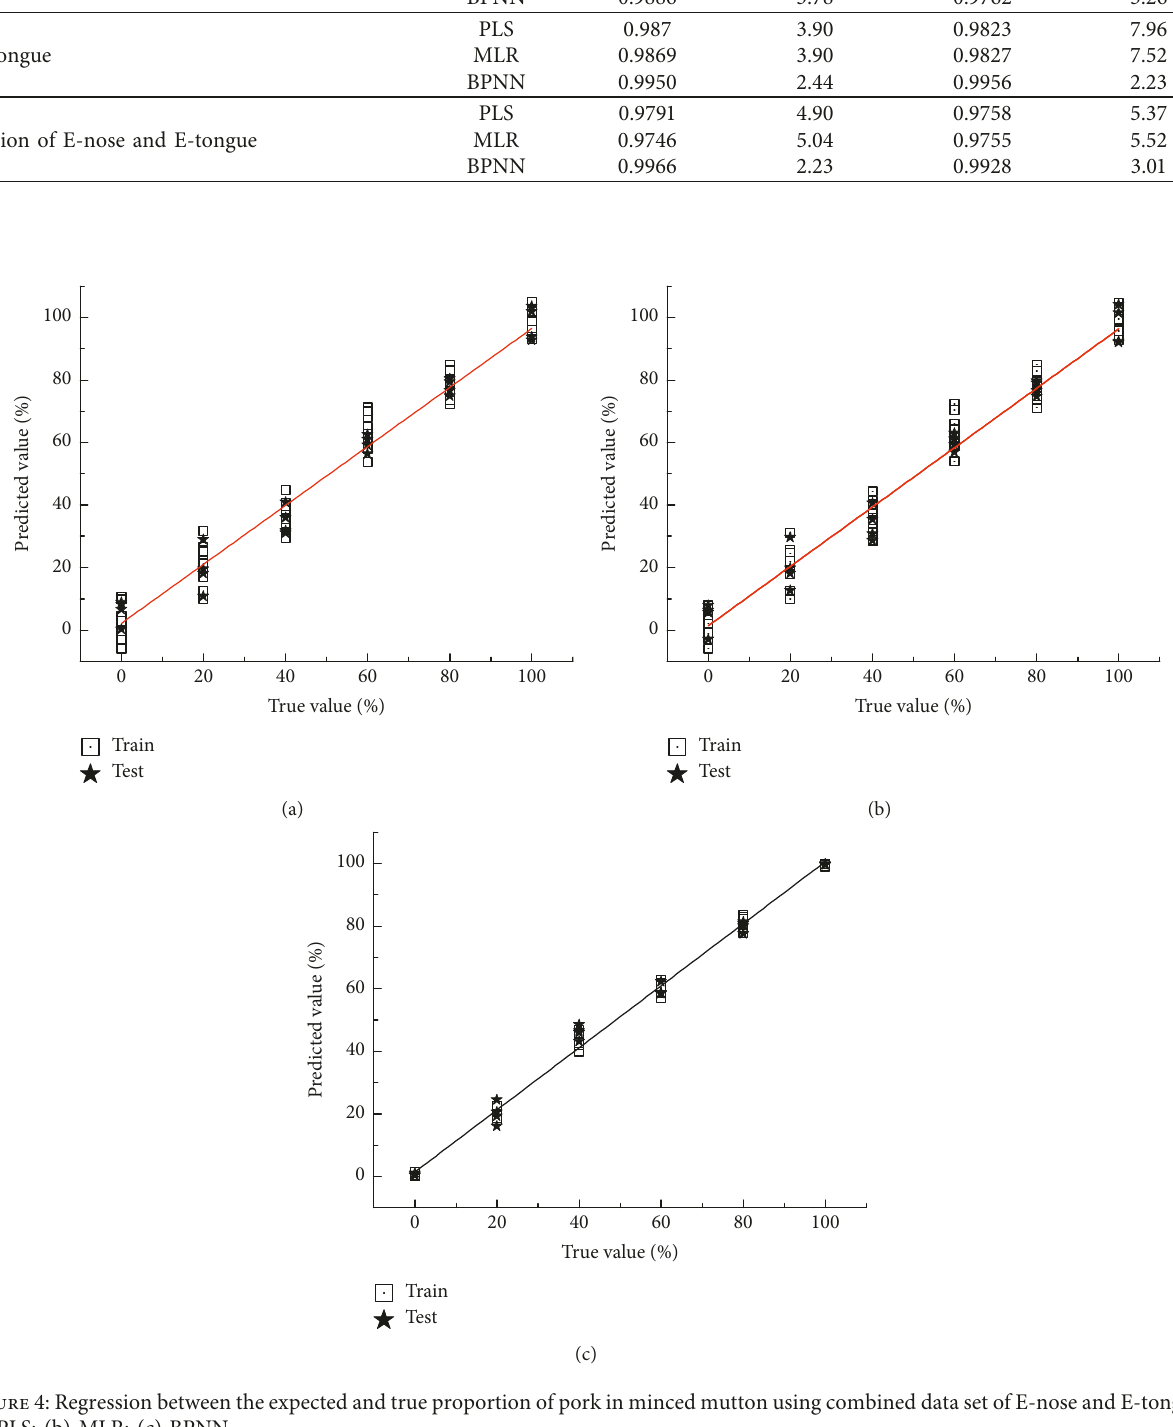
Figure 4: Regression between the expected and true proportion of pork in minced mutton using combined data set of E-nose and E-tongue: (a) PLS; (b) MLR; (c)